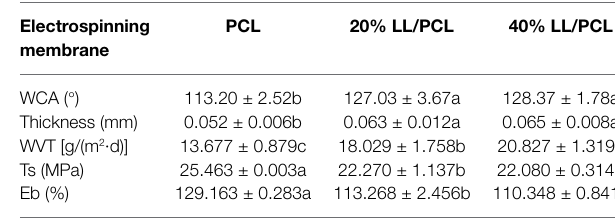
TABLE 1 | Physicochemical properties of LL/PCL fibrous